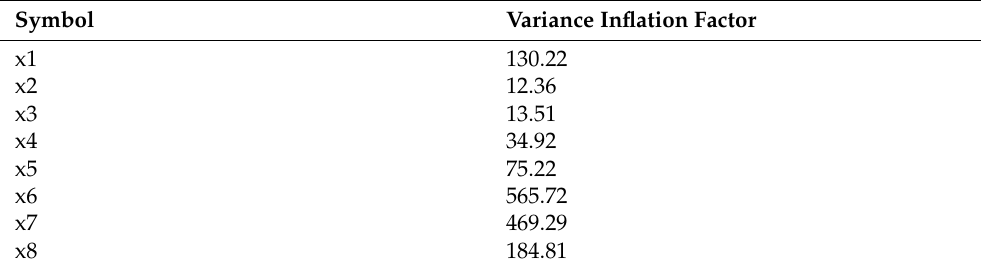
Table 9. Calculation result of variance inflation factor.